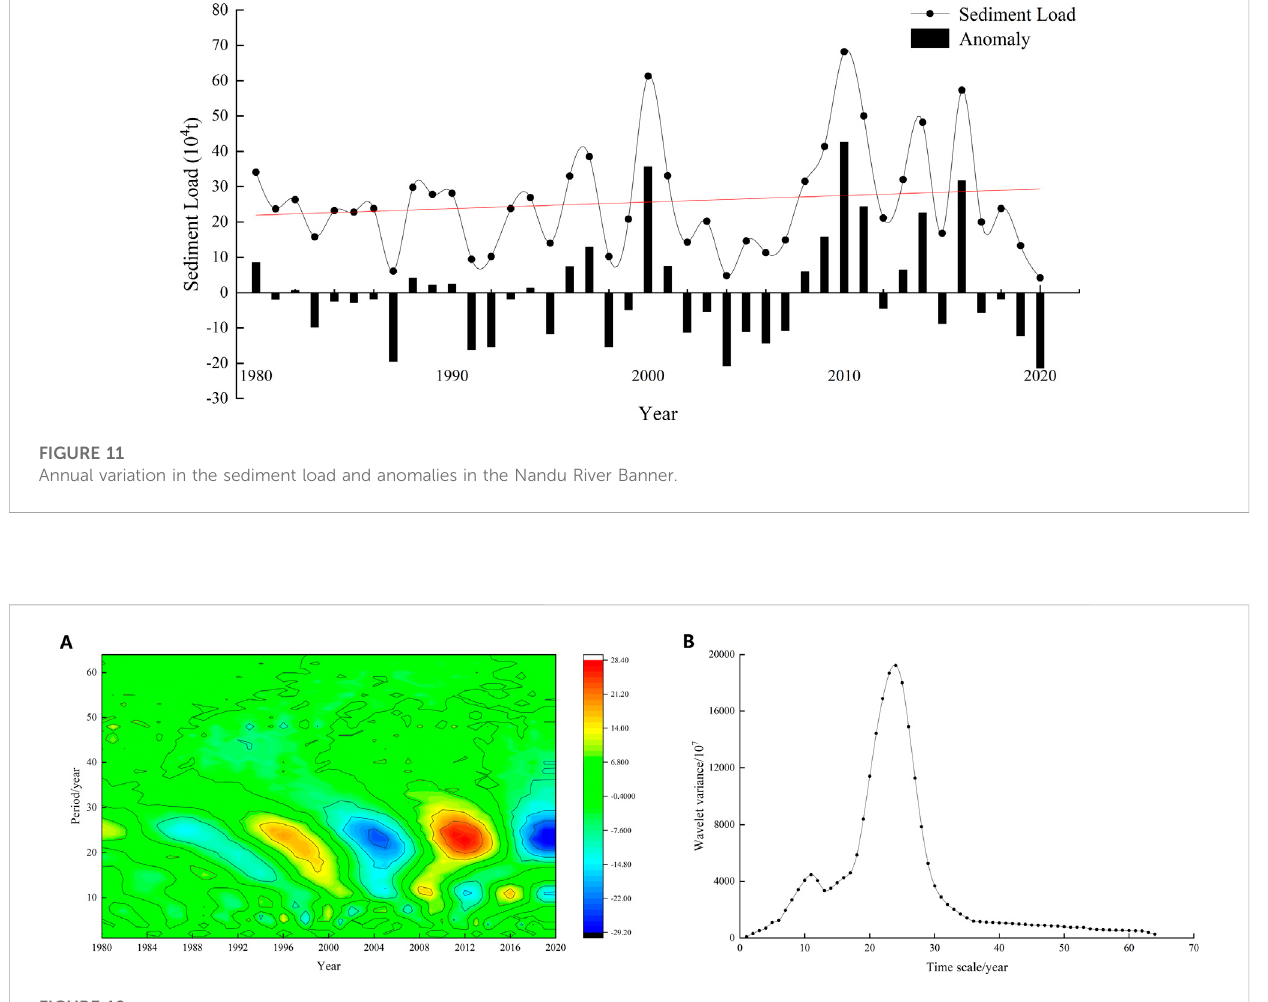
Periodic variation in the annual sediment load based on wavelet